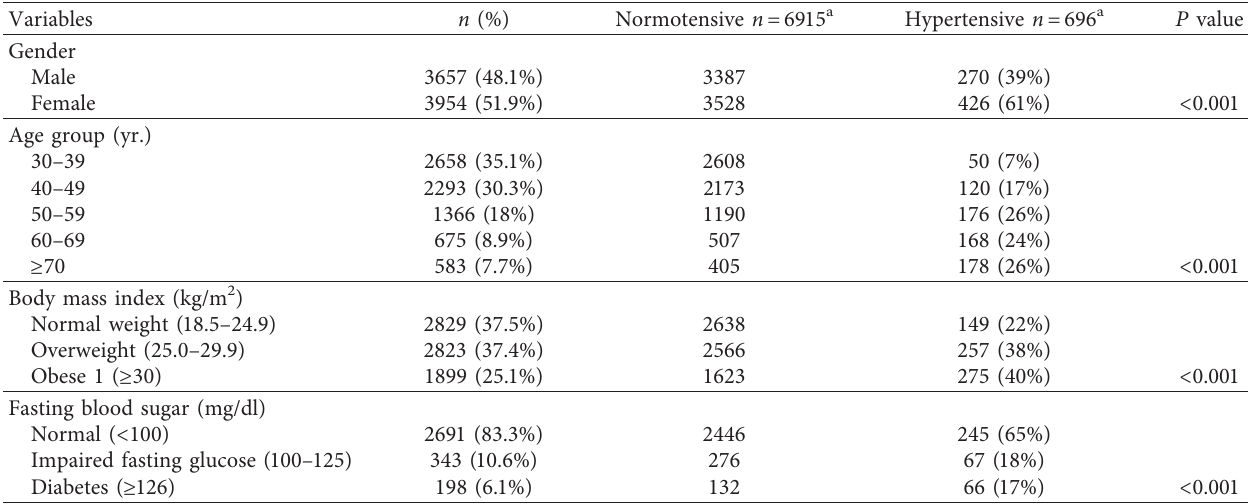
Table 1: Characteristics of the study sample ( n � 7612).